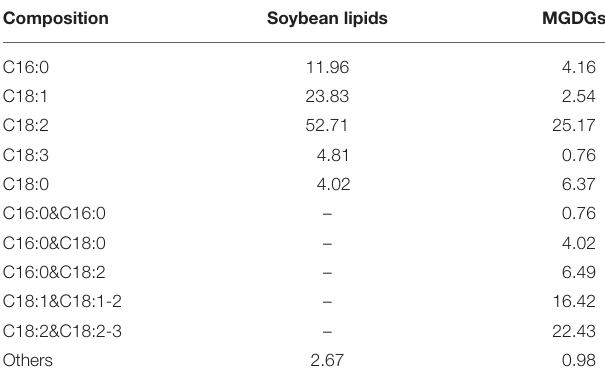
TABLE 1 | Ingredients and chemical compositions of the diets (as-fed basis). TABLE 2 | Fatty acid composition of the Soybean Lipids